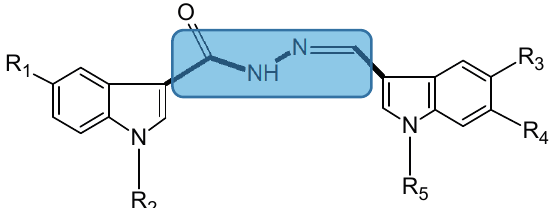
Figure 3. Chemical structure of bis(indolyl)hydrazide-hydrazone